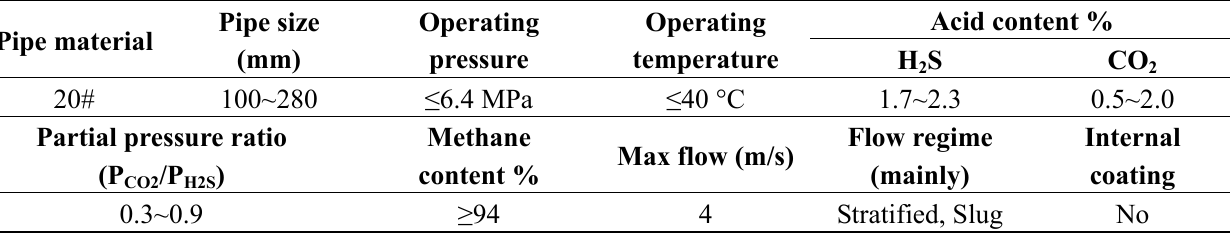
Table 7. The similar factors among the